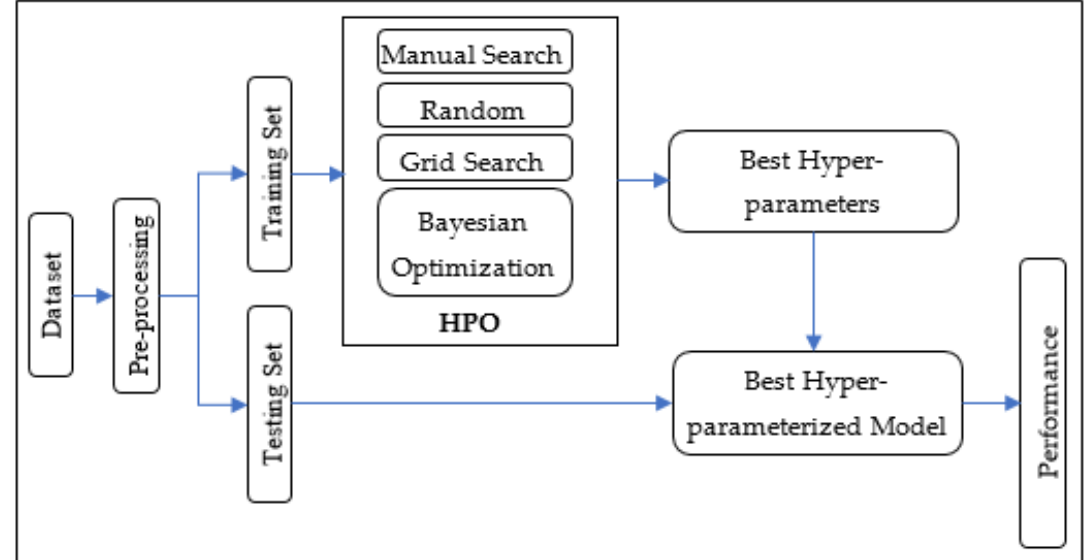
Figure 2. Methodology utilized for performance evaluations.